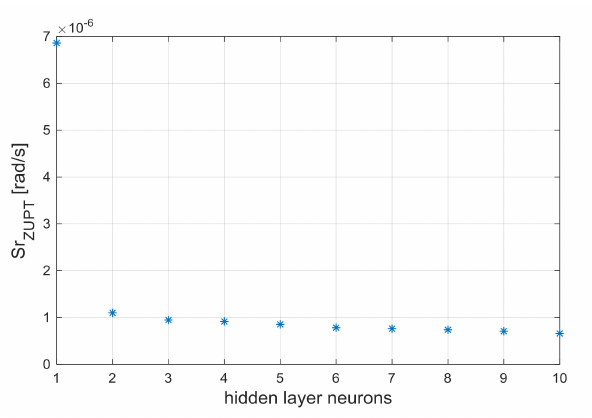
Figure 7. Performance parameter Sr ZUPT vs. number of hidden layers neurons (standard ZUPT filter).